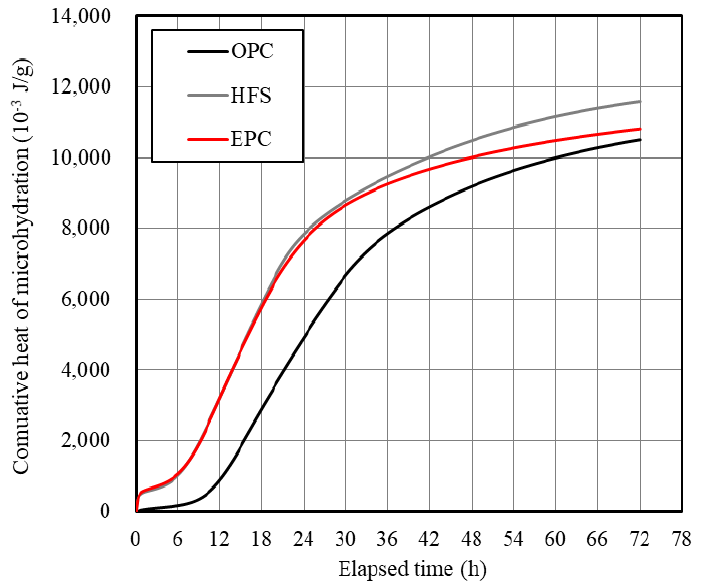
Figure 8. Cumulative microhydration heat according to the cement type.